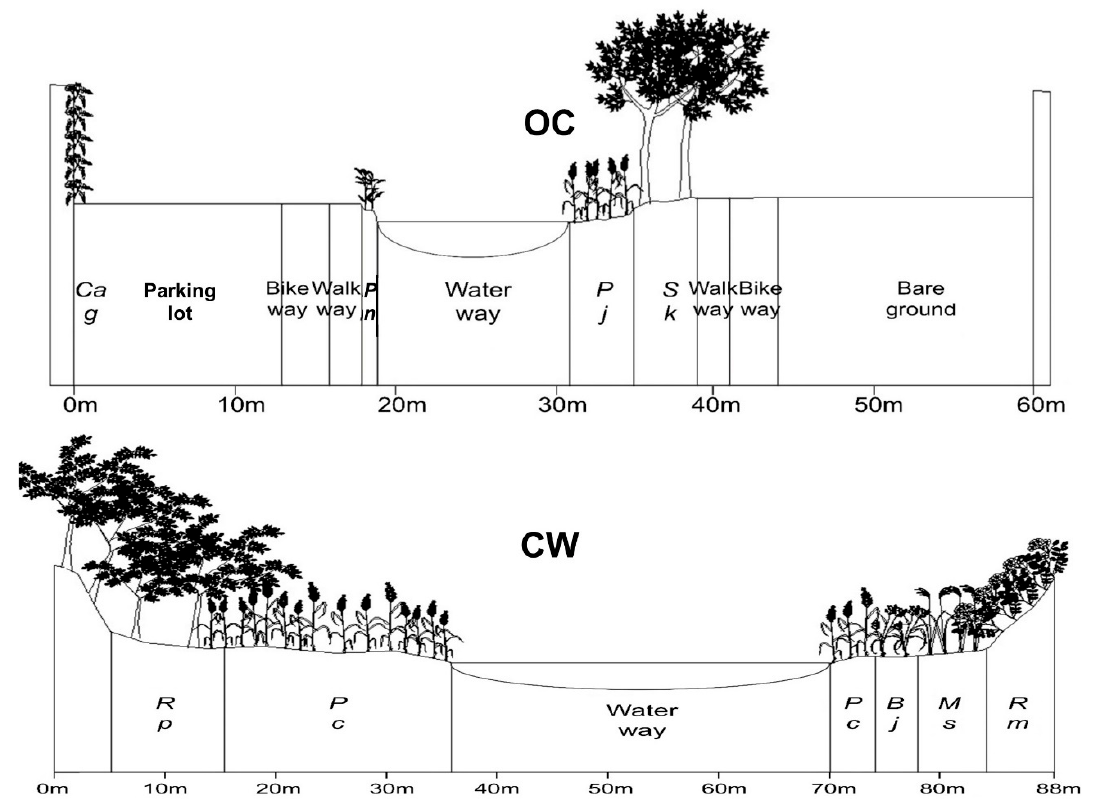
Figure 2. Stand profiles of riparian vegetation collected from the restored rivers. CW: Changwon